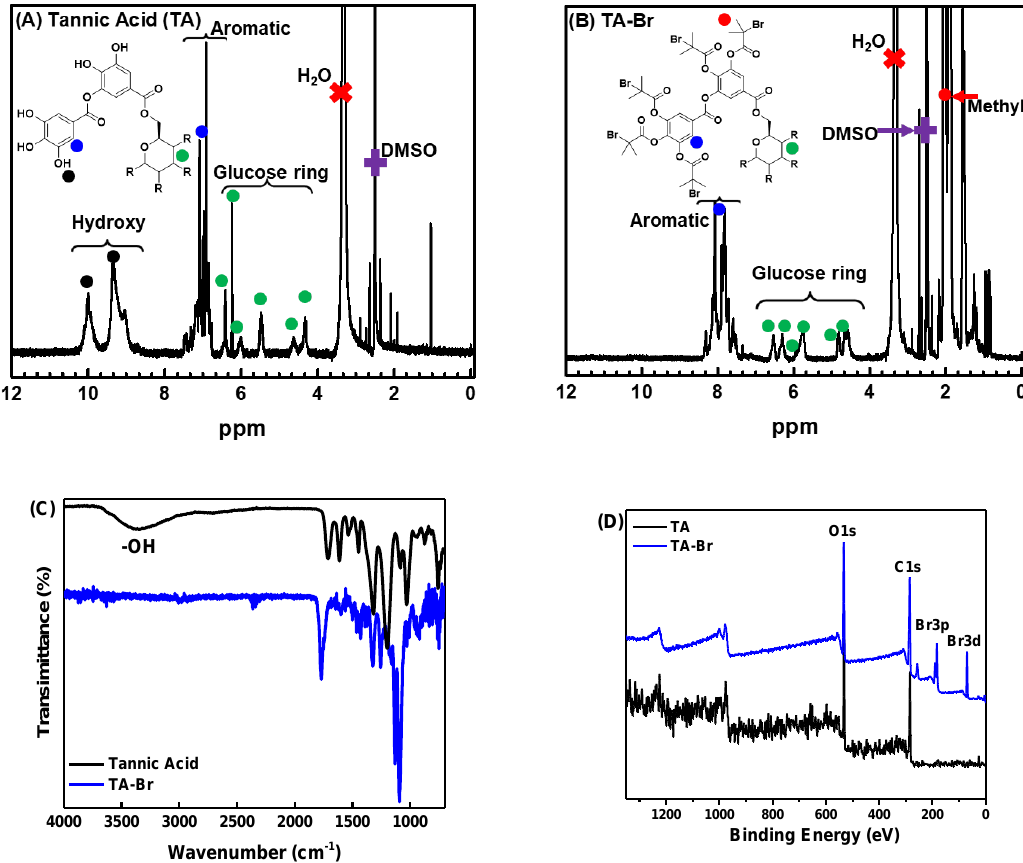
Figure 1. ( A ) The 1 H NMR spectra of tannic acid (TA) and ( B ) TA-Br with the peaks identified. For clarity, only one polyphenol arm of TA and TA-Br is shown (R = the 4 other identical phenol branches) and representative peaks are shown with colored circles. ( C ) FT-IR spectra of TA (black) and TA-Br (blue). ( D ) XPS survey spectra of TA (black) and TA-Br (blue).